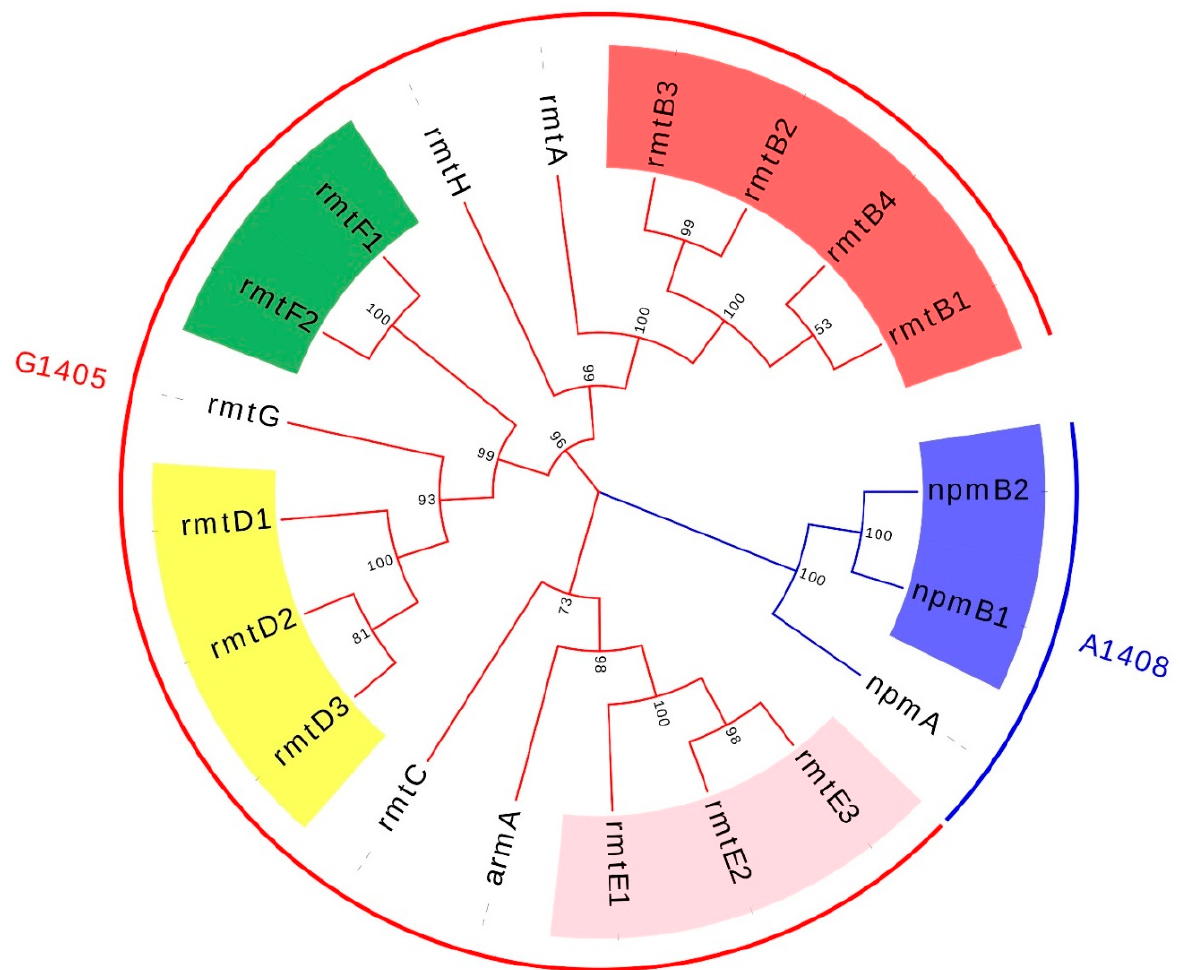
Figure 1. The phylogenetic reconstruction of 16S-RMTases encoding genes and their subtypes. The colors of the branch and external circle are typed by the action sites of 16S-RMTase. The subtypes of rmtB , rmtD , rmtE , rmtF , and npmA are highlighted with red, yellow, pink, green, and blue. GenBank: